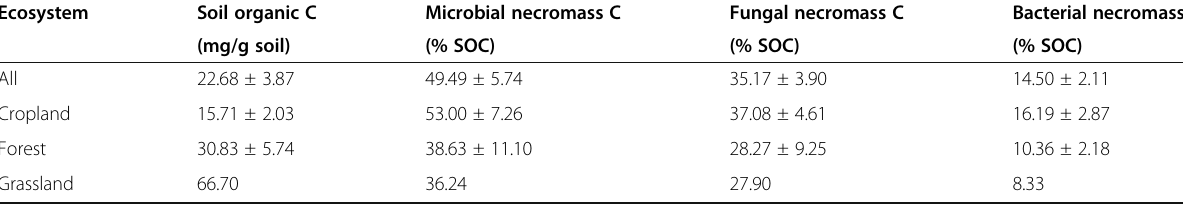
Table 2 Percentages of microbial necromass C in soil organic C in different ecosystems Ecosystem Soil organic C Microbial necromass C Fungal necromass C Bacterial necromass C (mg/g soil) (% SOC) (% SOC) (% SOC) All 22.68 ± 3.87 49.49 ± 5.74 35.17 ± 3.90 14.50 ± 2.11 Cropland 15.71 ± 2.03 53.00 ± 7.26 37.08 ± 4.61 16.19 ± 2.87 Forest 30.83 ± 5.74 38.63 ± 11.10 28.27 ± 9.25 10.36 ± 2.18 Grassland 66.70 36.24 27.90 8.33 Error bars are standard errors of the mean (except in grassland). All data were collected at the control plots without N addition and were the average values at each site C carbon, SOC soil organic